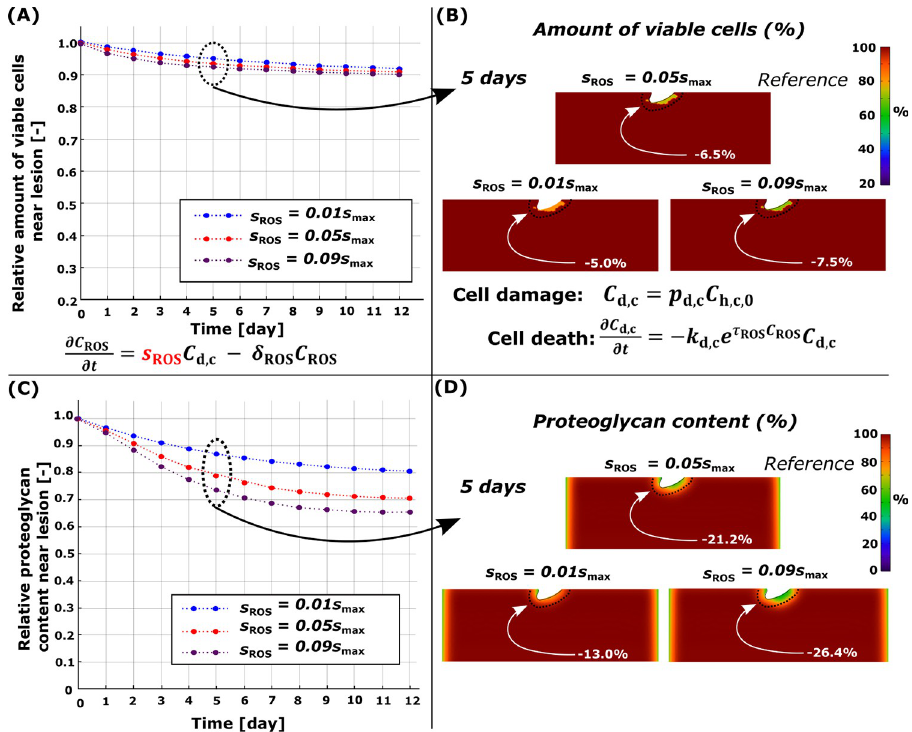
Fig 5. Sensitivity analysis of simulated reactive oxygen species (ROS) production rate s ROS . Comparison of temporal and spatial changes at day 5 (A)-(B) in cell viability and (C)-(D) in proteoglycan (PG) content. (C) Higher simulated ROS production showed more intensive temporal PG loss and (A) cell death near the cartilage lesion compared to moderate and low production rates. Red line in (A) and (C) refers to the reference model ( s ROS = 0.40).